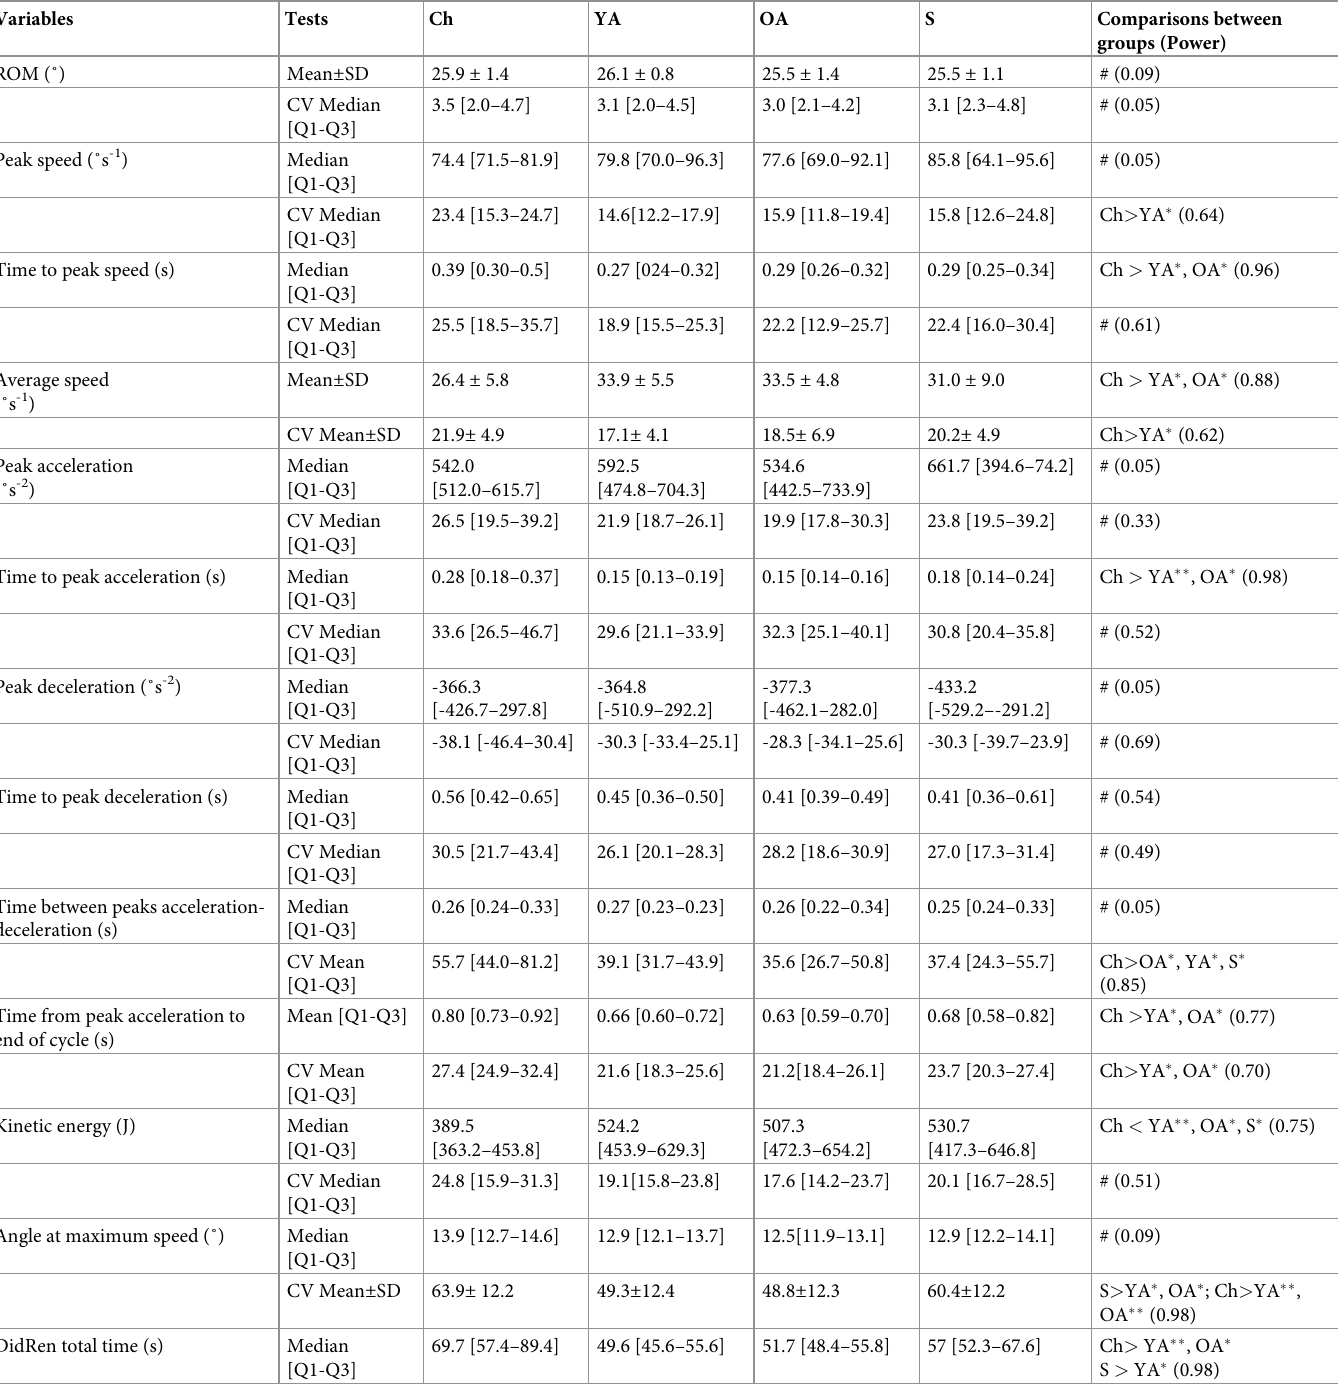
Table 2. Results for variables collected during the DidRen test according to the four age